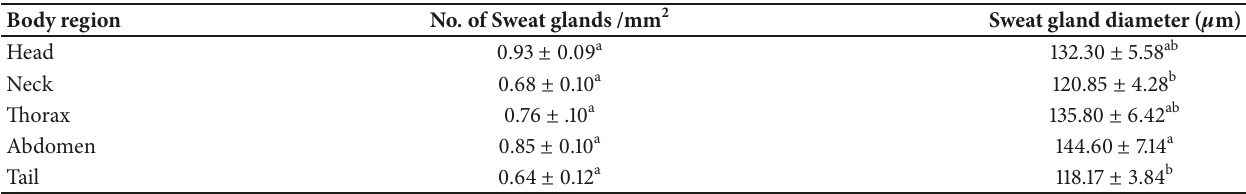
Figure 1: Graph showing distribution of no. of sweat glands/mm 2 in different areas of body regions. Table 2: No. of sweat glands/mm 2 and diameter of sweat gland in different body